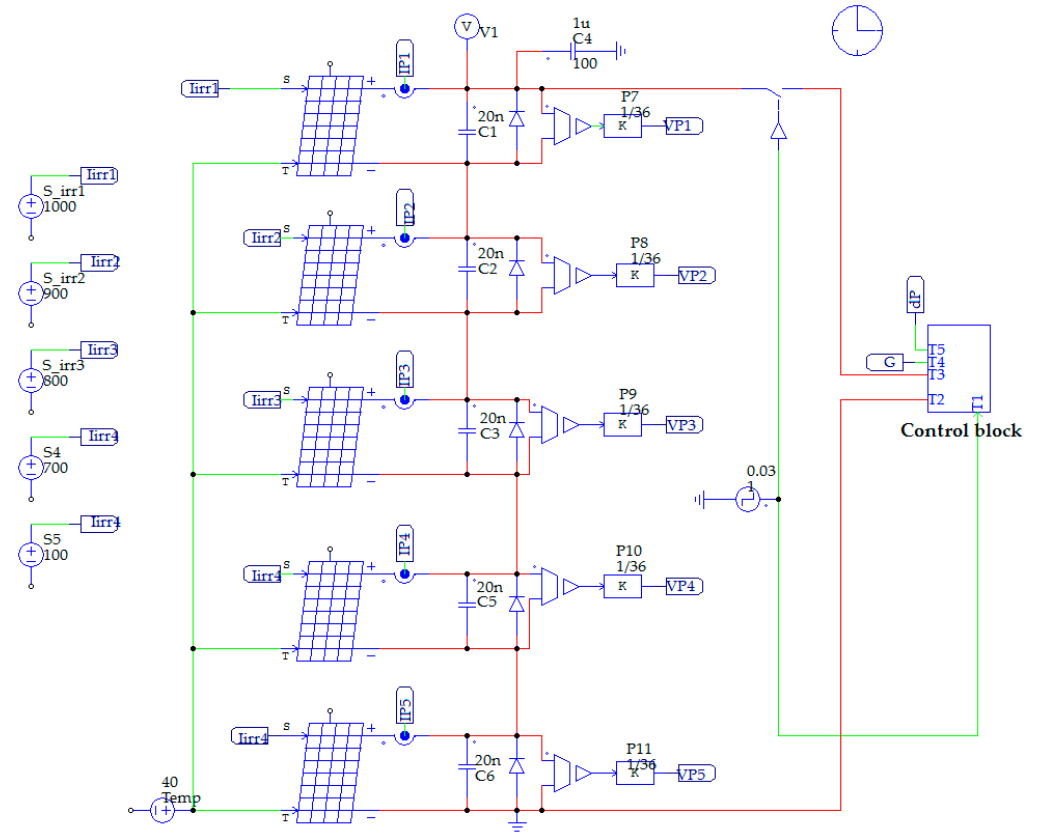
Figure 6. The PSIM circuit for MPPT control.